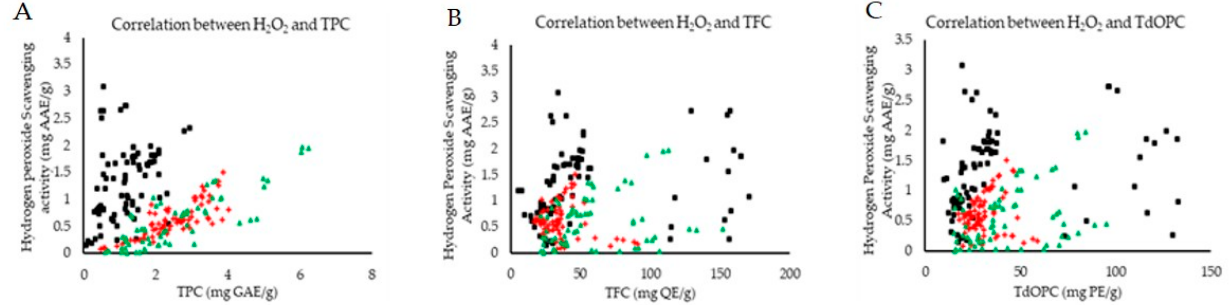
Figure 11. ( A ) Correlation between TPC and hydrogen peroxide scavenging activity. The ρ -value of methanolic extracts ( (cid:4) ) was 0.42, for acidic hydrolysis (+) it was 0.80 and for alkaline hydrolysis ( (cid:78) ) it was 0.85. ( B ) Correlation between TFC and hydrogen peroxide scavenging activity. The ρ -value of methanolic extracts ( (cid:4) ) was 0.45, for acidic hydrolysis (+) it was − 0.60 and for alkaline hydrolysis ( (cid:78) ) it was 0.55. ( C ) Correlation between TdOPC and hydrogen peroxide. The ρ -value of methanolic extracts was 0.46, for acidic hydrolysis (+) it was0.18 and for alkaline hydrolysis ( (cid:78) ) it was